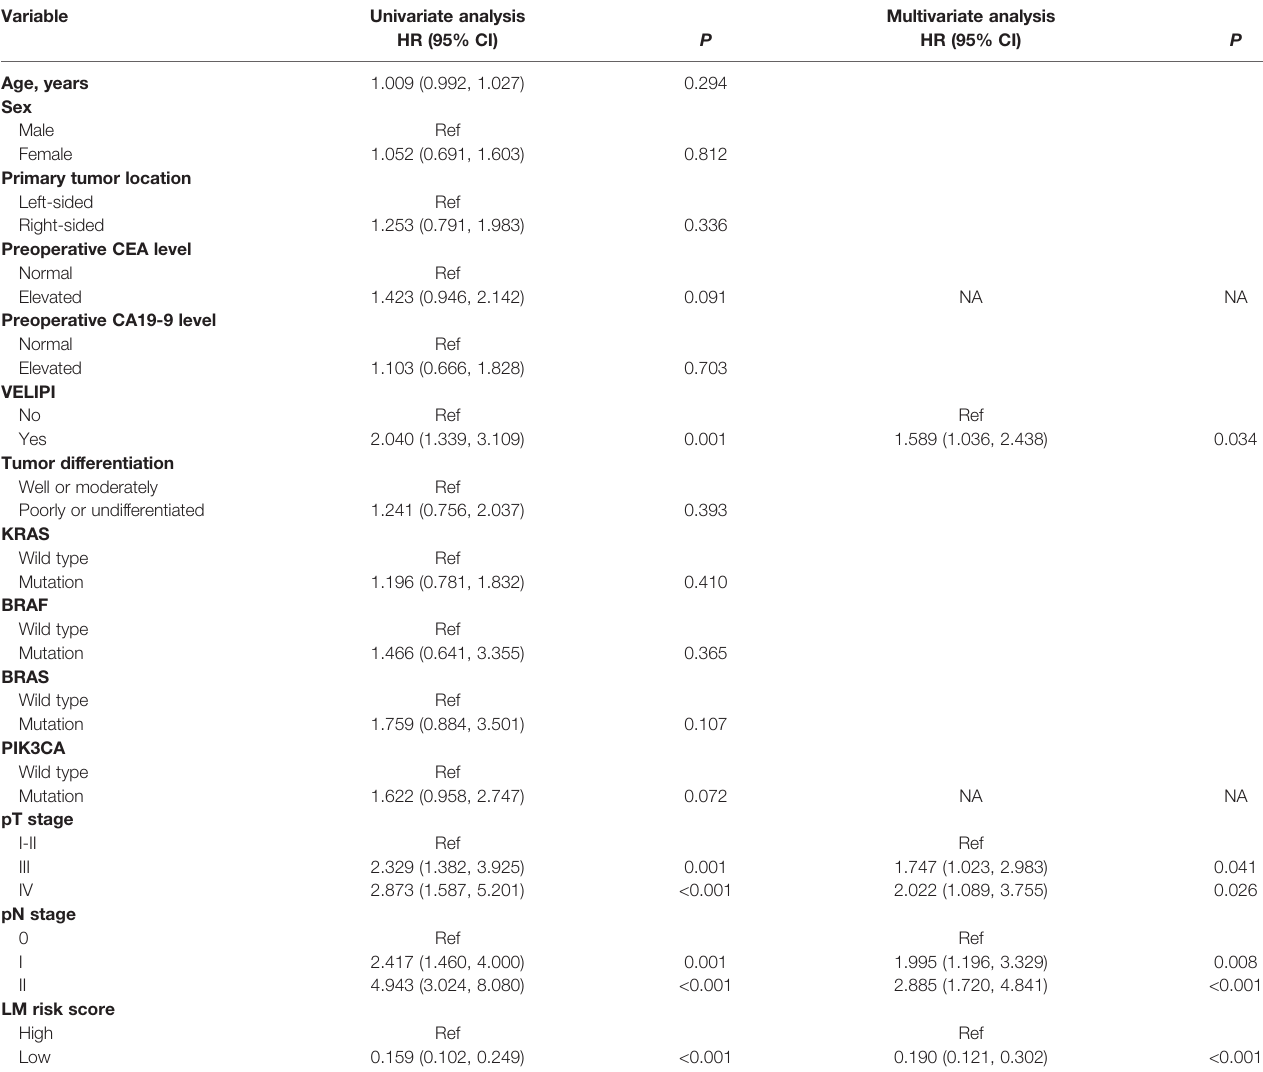
TABLE 2 | Univariate and multivariate Cox regression in the training